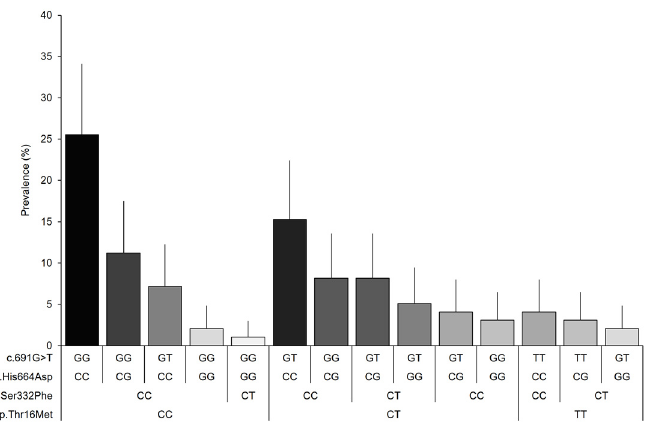
Figure 2. Genotypic prevalence based on the combination of the analyzed variants of the AOC1 gene. Error bars represent 95% CIs.